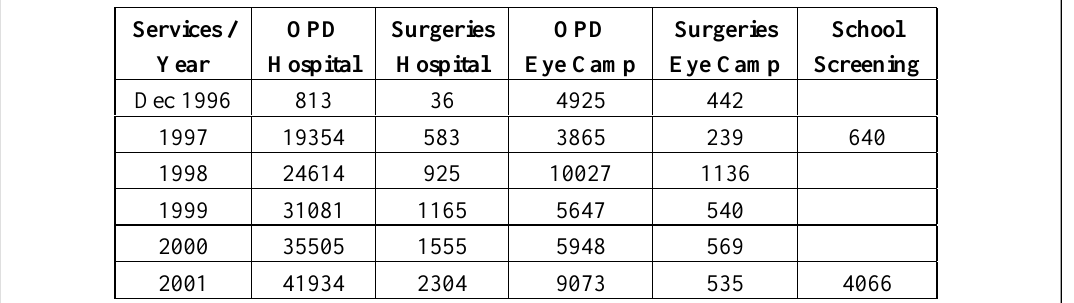
Table I : Clinical Activities : Services of Mechi Eye Care